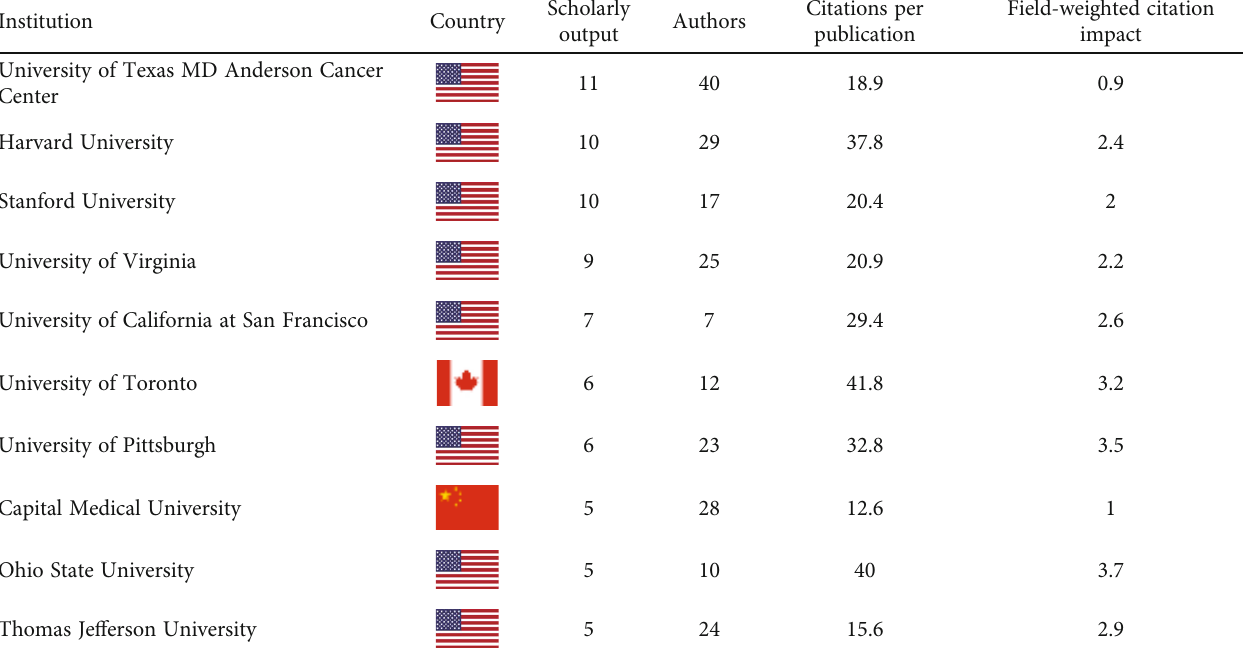
Table 5: Top 10 institutions (%) publishing about knife